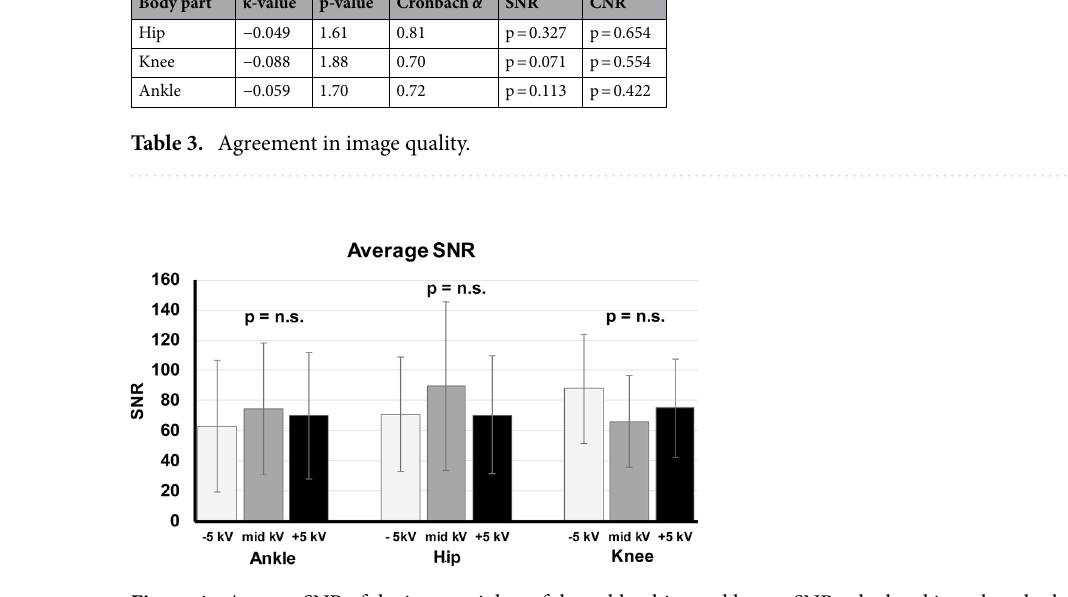
Figure 4. Average SNR of the image triplets of the ankles, hips and knees. SNR calculated in trabecular bone showed no significant changes within the image triplets (with ± 5 kV tube voltage variation) in ankle, hip and